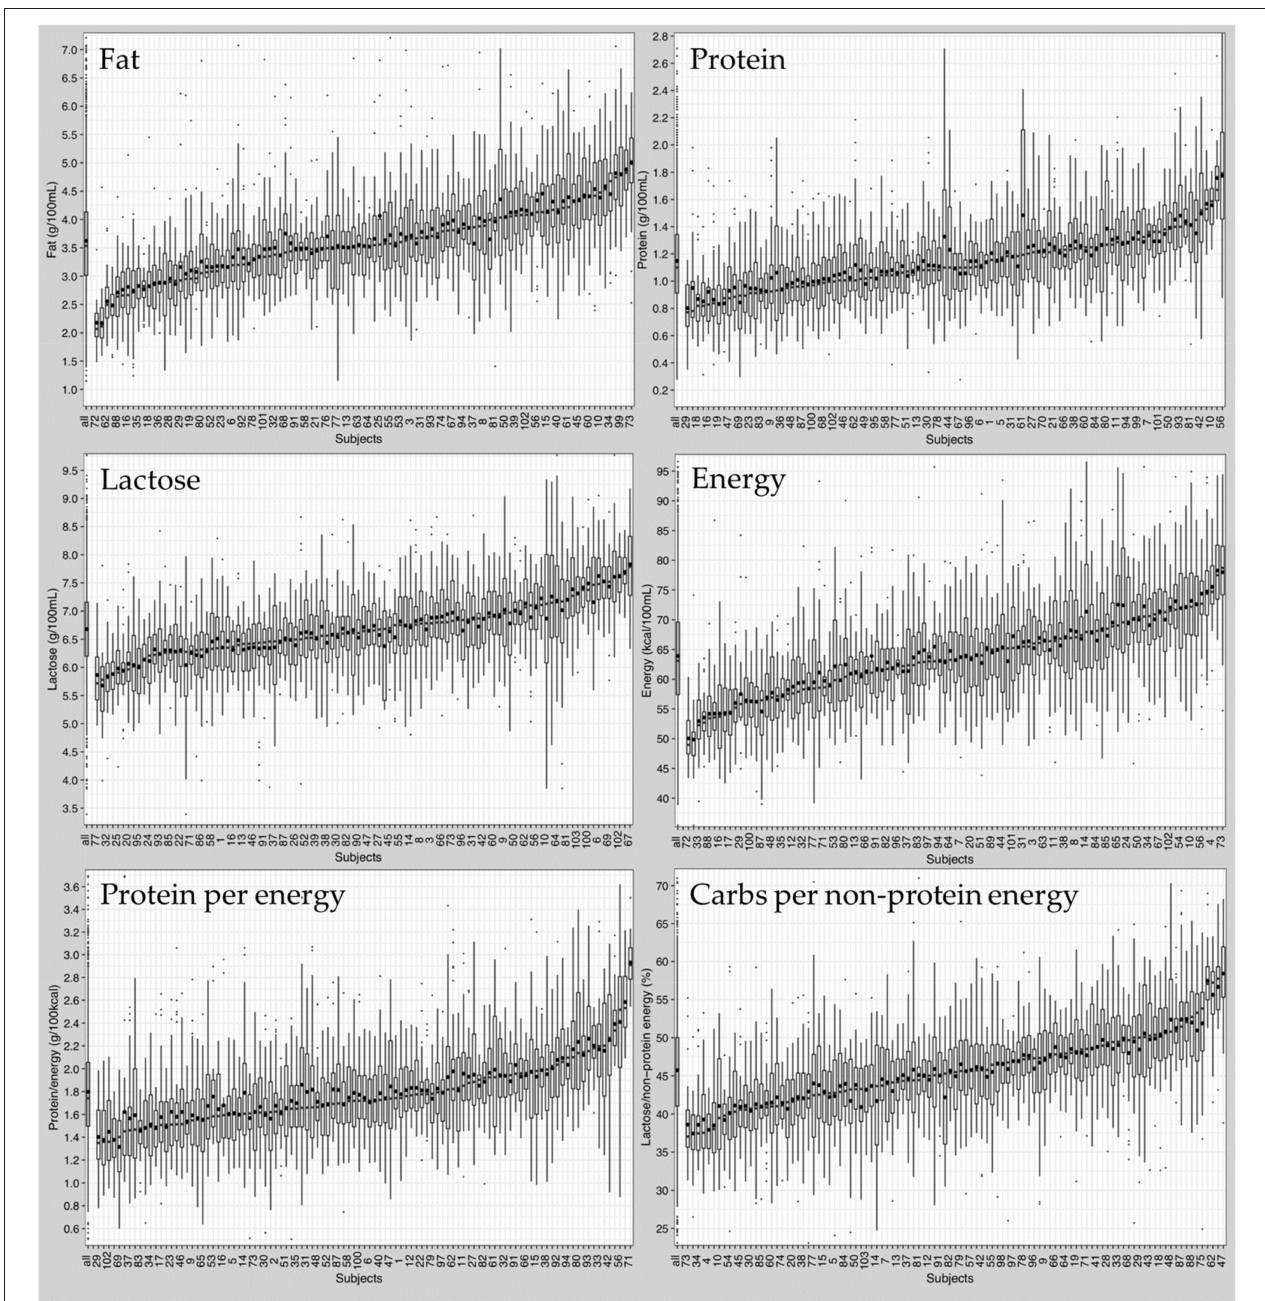
FIGURE 5 | Composition of native breast milk presented in ascending order of median nutrient content per subject. Boxplots display median values of all subjects (left boxplot) and of individual subjects (103 boxplots). Circles represent mean values, dots represent outliers.